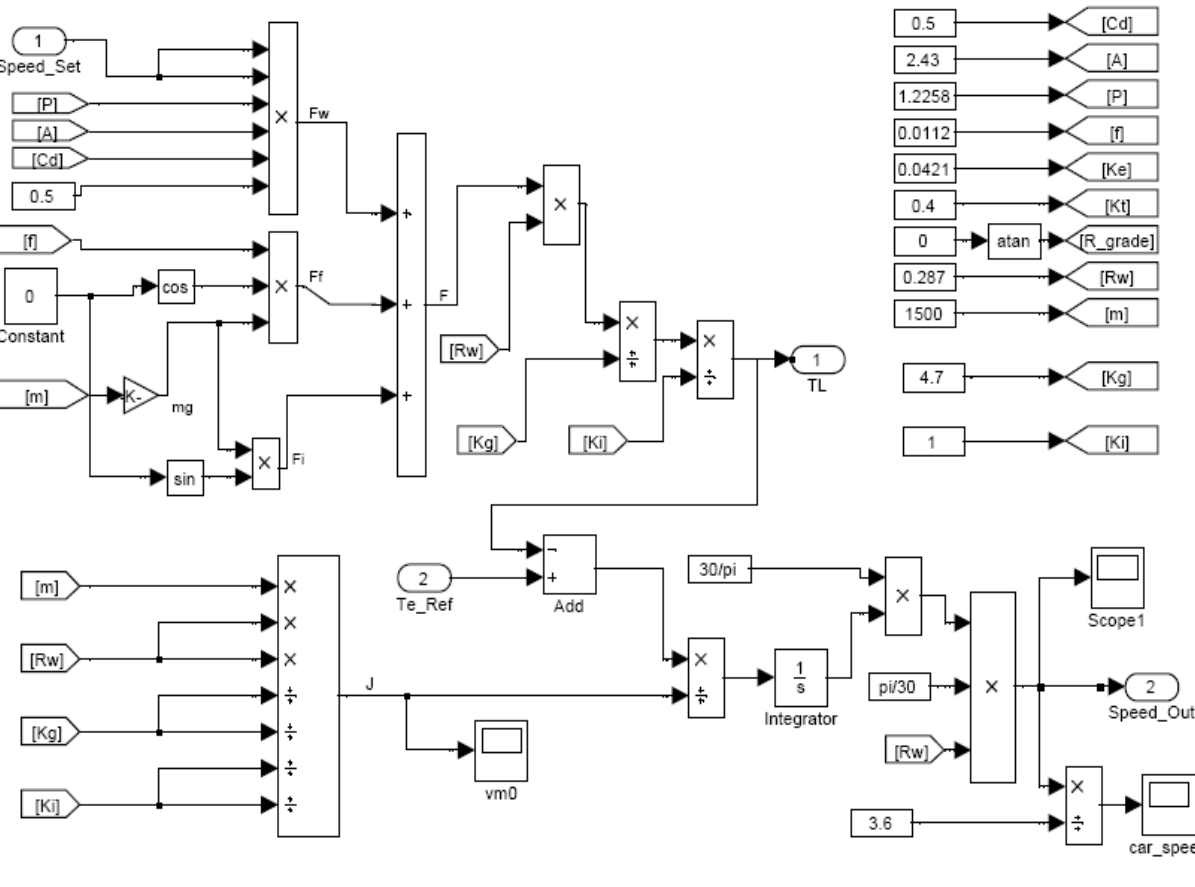
Figure 3. Simulation model of the dynamic system for